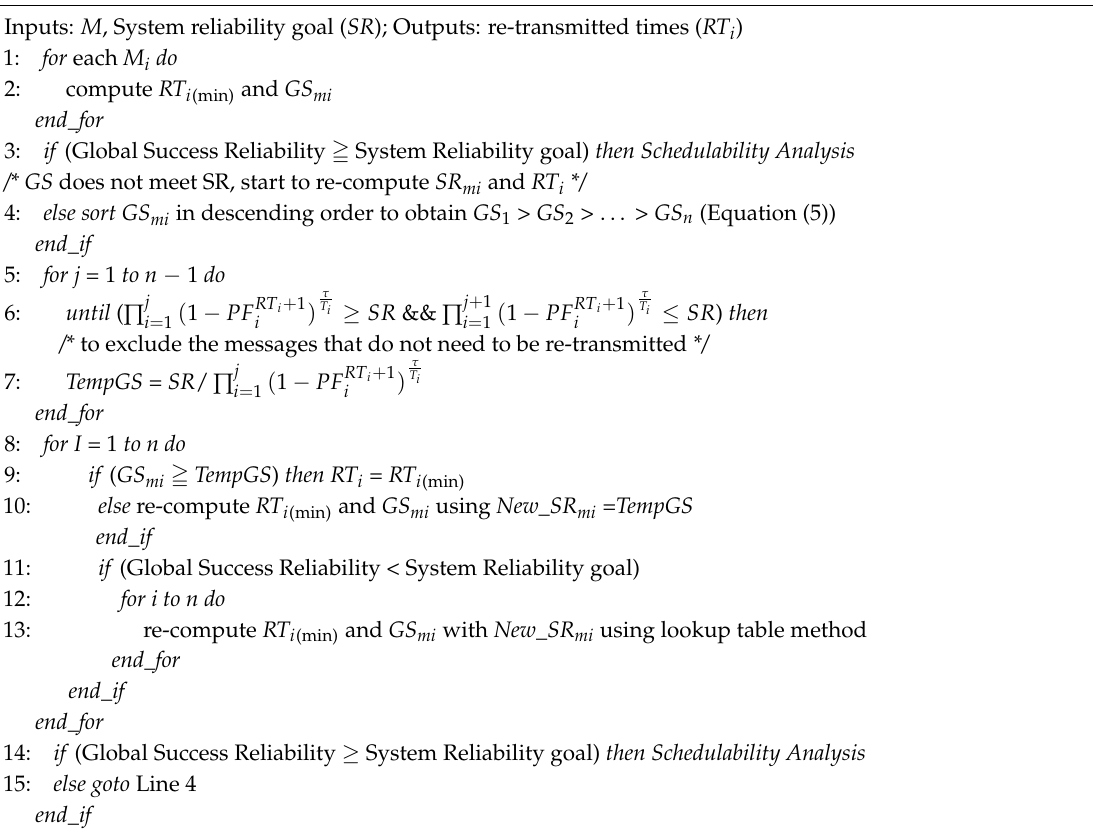
Algorithm 1 The proposed fast reliability scheduling